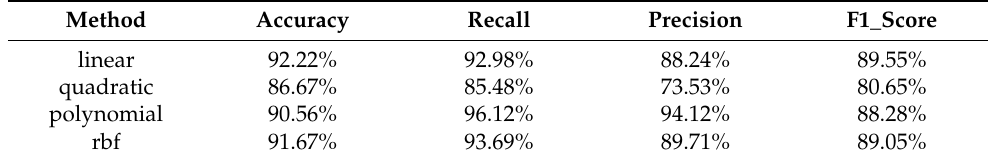
Table 4. Testing results without feature selection.